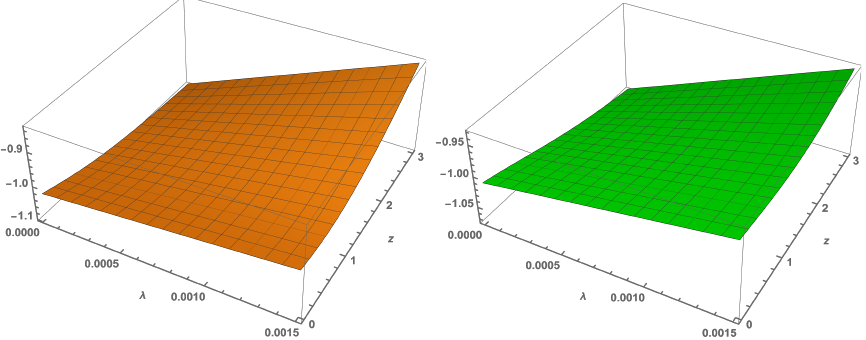
Figure 10. The behavior of the EoS parameter against the redshift parameter z and λ with the constraint values of the coefficients in (29) and γ = 15, β = − 0.5 for f ( Q ) = γ + β log Q . Left side graph for Hubble data and right side graph for Pantheon